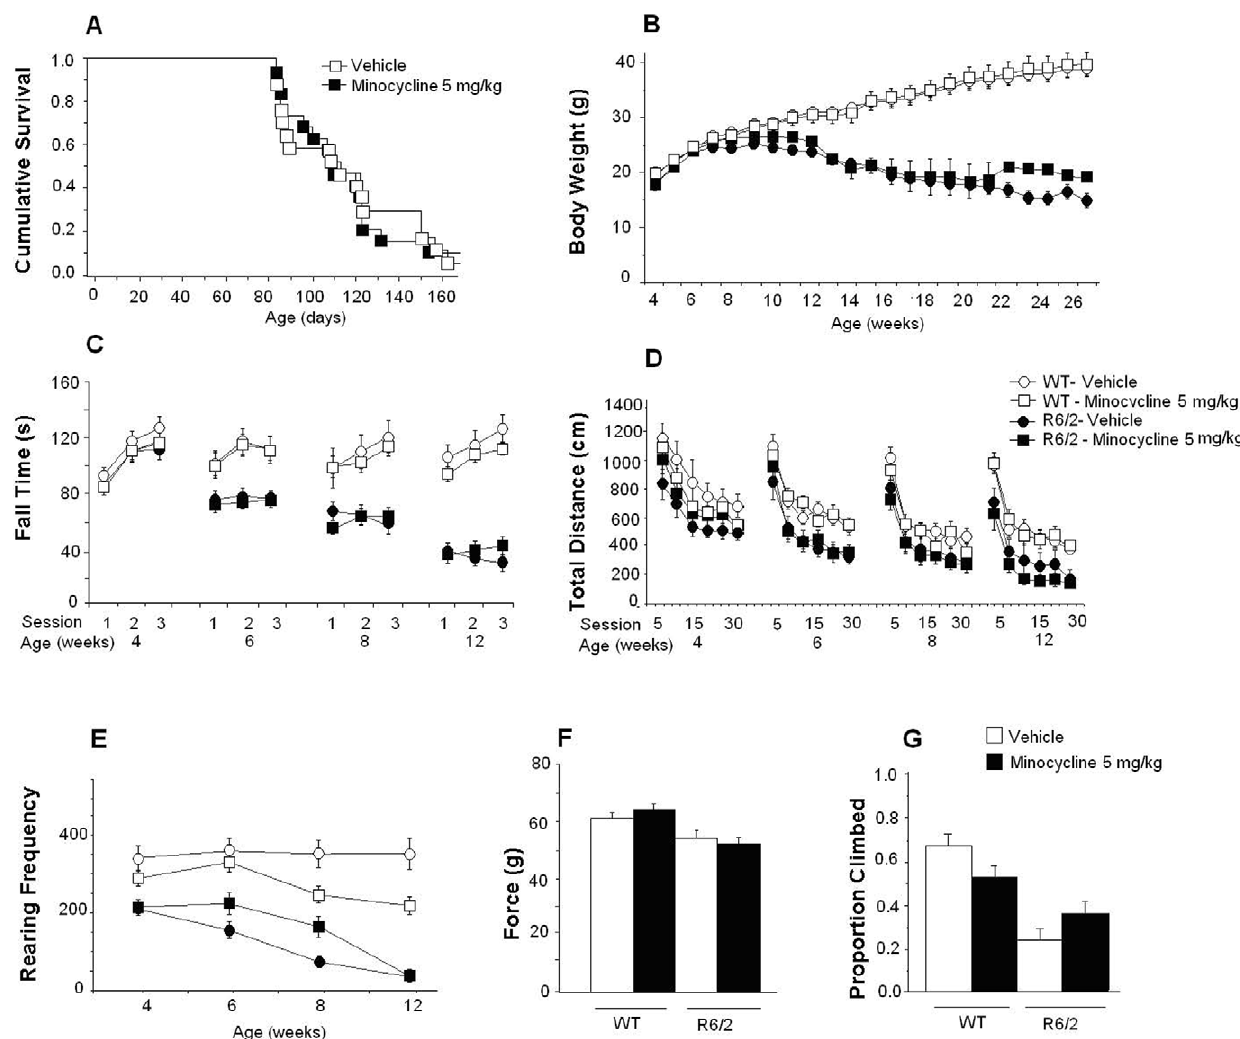
Figure 3. Effect of daily i.p. administration of 5mg/kg of minocycline in R6/2 mice. WT and R6/2 mice received either 5mg/kg of minocycline or its vehicle by intraperitoneal injection. Minocycline had no effects on survival (A) on either R6/2 or WT mice, but transiently increased the body weight (B) of mutant male mice at 8, 10, 11 and 12 weeks of age (treatment 6 gender 6 age interaction: F(22,312)=4.2, p , 0.0001; simple main effects: ps , 0.05). In the WT group, minocycline did not produce significant effects in body weight. In the rotarod test (C), although there was a triple interaction of treatment, age and day for R6/2 mice, simple main effects did not reveal a consistent pattern (overall effects: treatment 6 age 6 day interaction: F(10,143)=3.2, p , 0.001). There were no effects for the WT mice. Minocycline transiently increased locomotion (D) in R6/2 male mice (treatment 6 gender 6 age: F(6,87)=4.5; p , 0.0005; simple main effects: ps , 0.05 at 4 weeks of age) but decreased locomotion in the male WT mice (treatment 6 gender 6 week interaction, F(6,102)=2.6, p , 0.03, simple main effects and post hocs, ps , 0.05 at 4 weeks of age). Rearing frequency (E) was transiently decreased by minocycline in female R6/2 mice at 6 weeks, but increased in male R6/2 mice at 6 and 8 weeks of age (treatment 6 gender interaction: F(1,33)=11.2, p , 0.002; treatment 6 age interaction: F(3,87)=6.4, p , 0.001; treatment 6 gender 6 age interaction: F(6,87)=5.4, p , 0.0001; simple main effects: ps , 0.05). Minocycline decreased rearing in WT mice at 8 and 12 weeks of age especially in the male group (treatment 6 gender interaction, F(1,37)=9.9, p , 0.0005; treatment 6 age interaction: F(3,102)=8.9, p , 0.0001, simple main effects, ps , 0.05). Minocycline did not affect grip strength (F) or rearing (G) in either R6/2 or WT mice although the latter showed a tendency to rear less (p , .07).